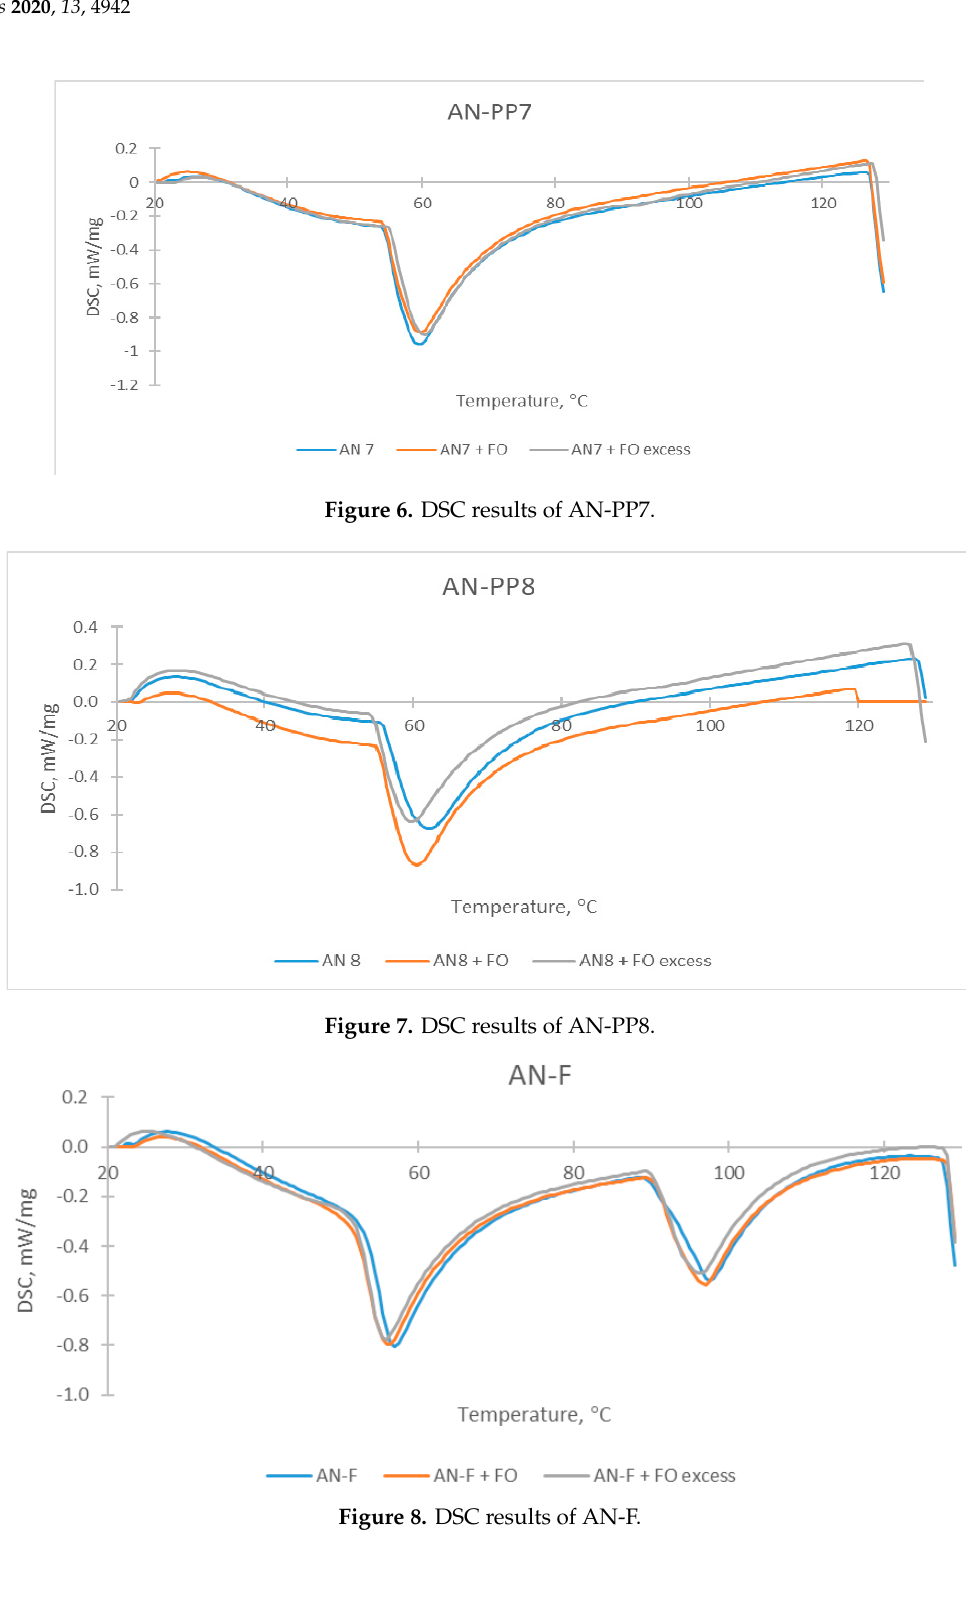
Figure 5. TG results of AN-F.